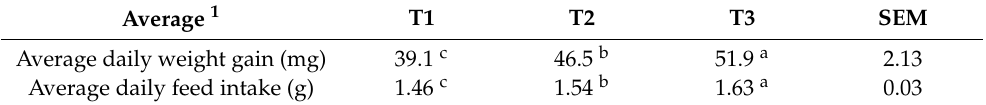
Table 4. Average body weight and feed intake of mice when supplemented with different treatment.